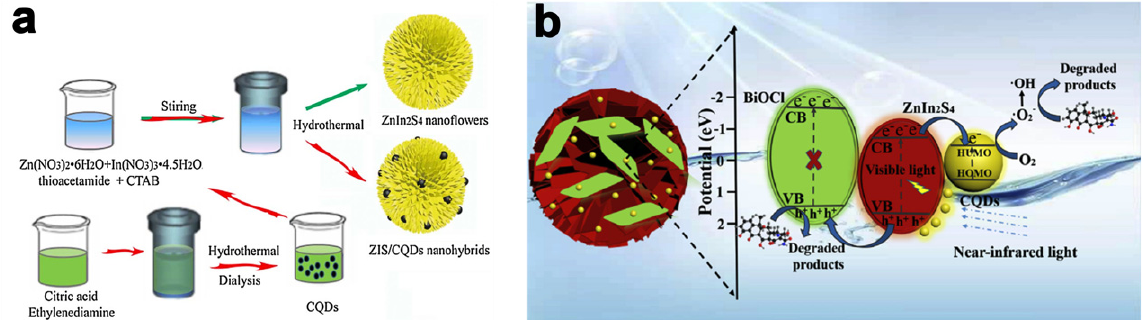
Figure 5. ( a ) Schematic illustration for the preparation method of ZnIn 2 S 4 /CQDs composites. Reprinted with permission from Ref. [59]. Copyright 2018, Elsevier. ( b ) Photocatalytic reaction mechanism of CQDs/ ZnIn 2 S 4 /BiOCl heterostructures for antibiotic removal at visible and NIR region. Reprinted with permission from Ref. [60]. Copyright 2019, Elsevier.